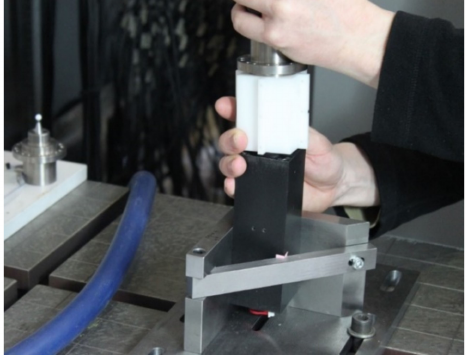
Figure 7. Photo showing calibration of the prototype interface as installed in the calibration